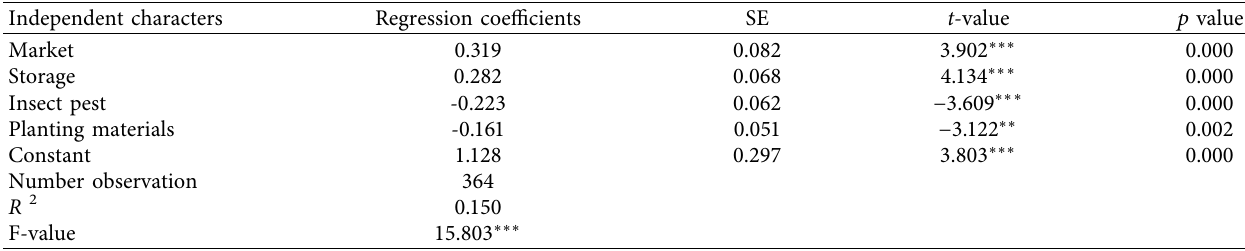
Table 6: Multiple regression outcomes for causes affecting the yield of OFSP.